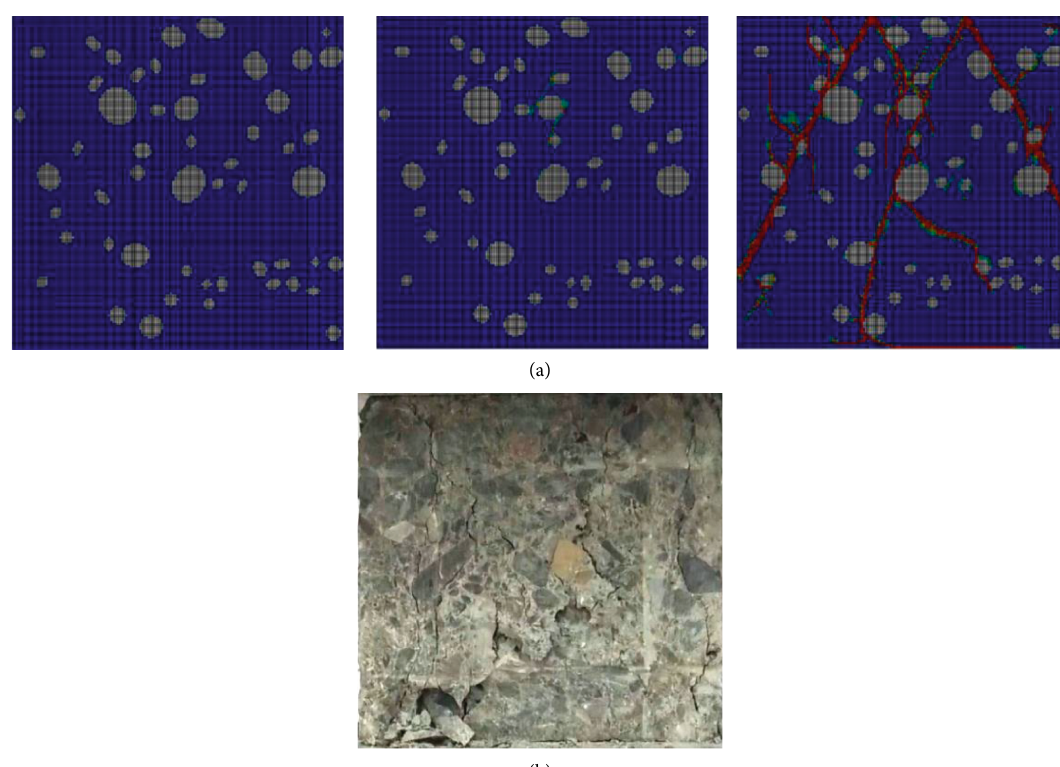
Figure 10: Failure morphology of RCA-0% cube under compression. (a) Simulation diagram of cubic compression fracture extension. (b) Test diagram of cubic compression fracture extension.